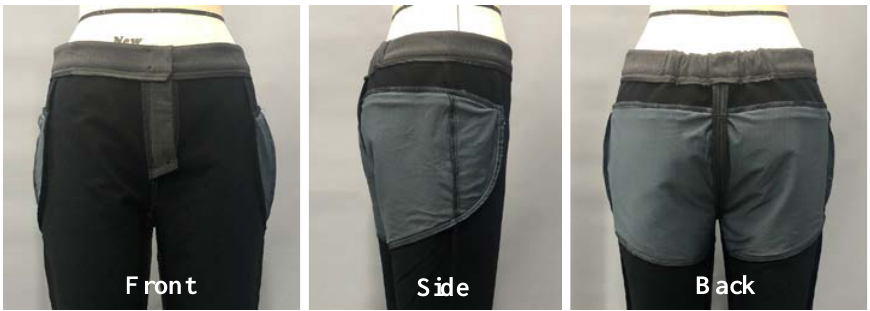
Figure 3. Pocket construction inside the pants.